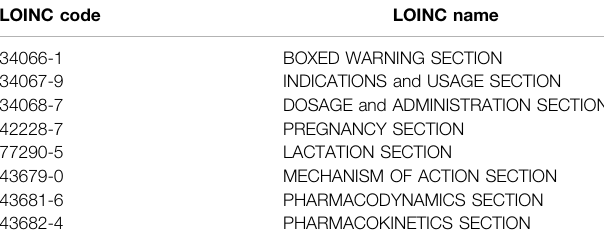
TABLE 2 | LOINC of selected sections from drug labeling in